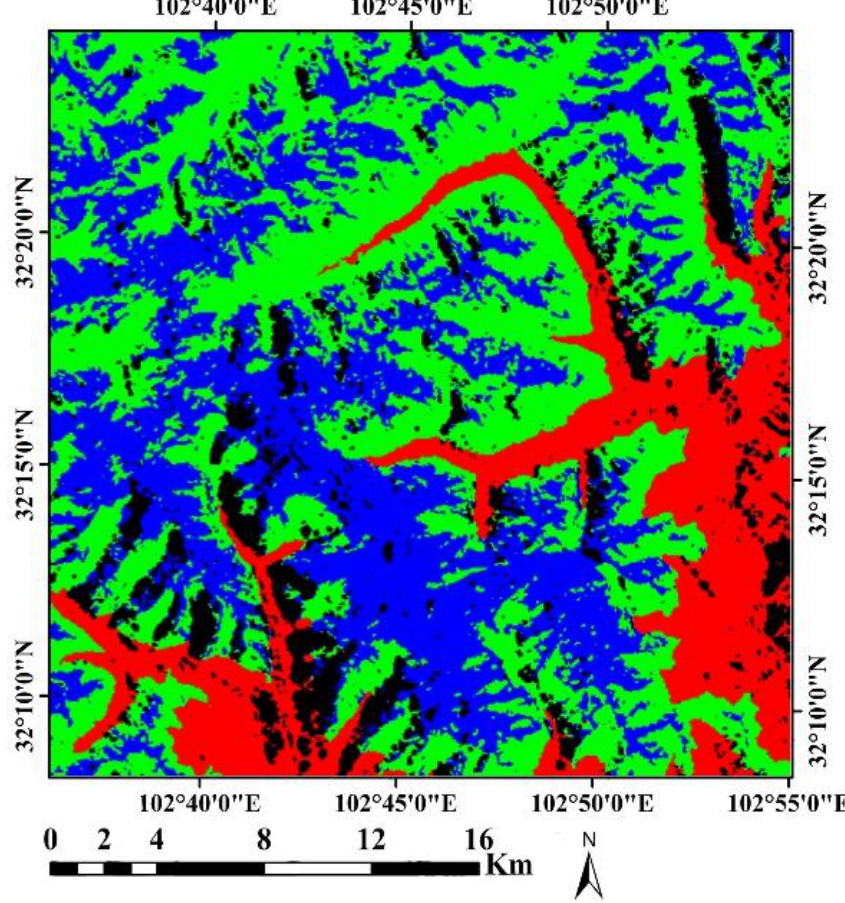
Figure 7. Snow map derived from γ temporal of 20080408–20080524. Areas with snow decrease, without snow change, and below tree line are blue, green, and red,